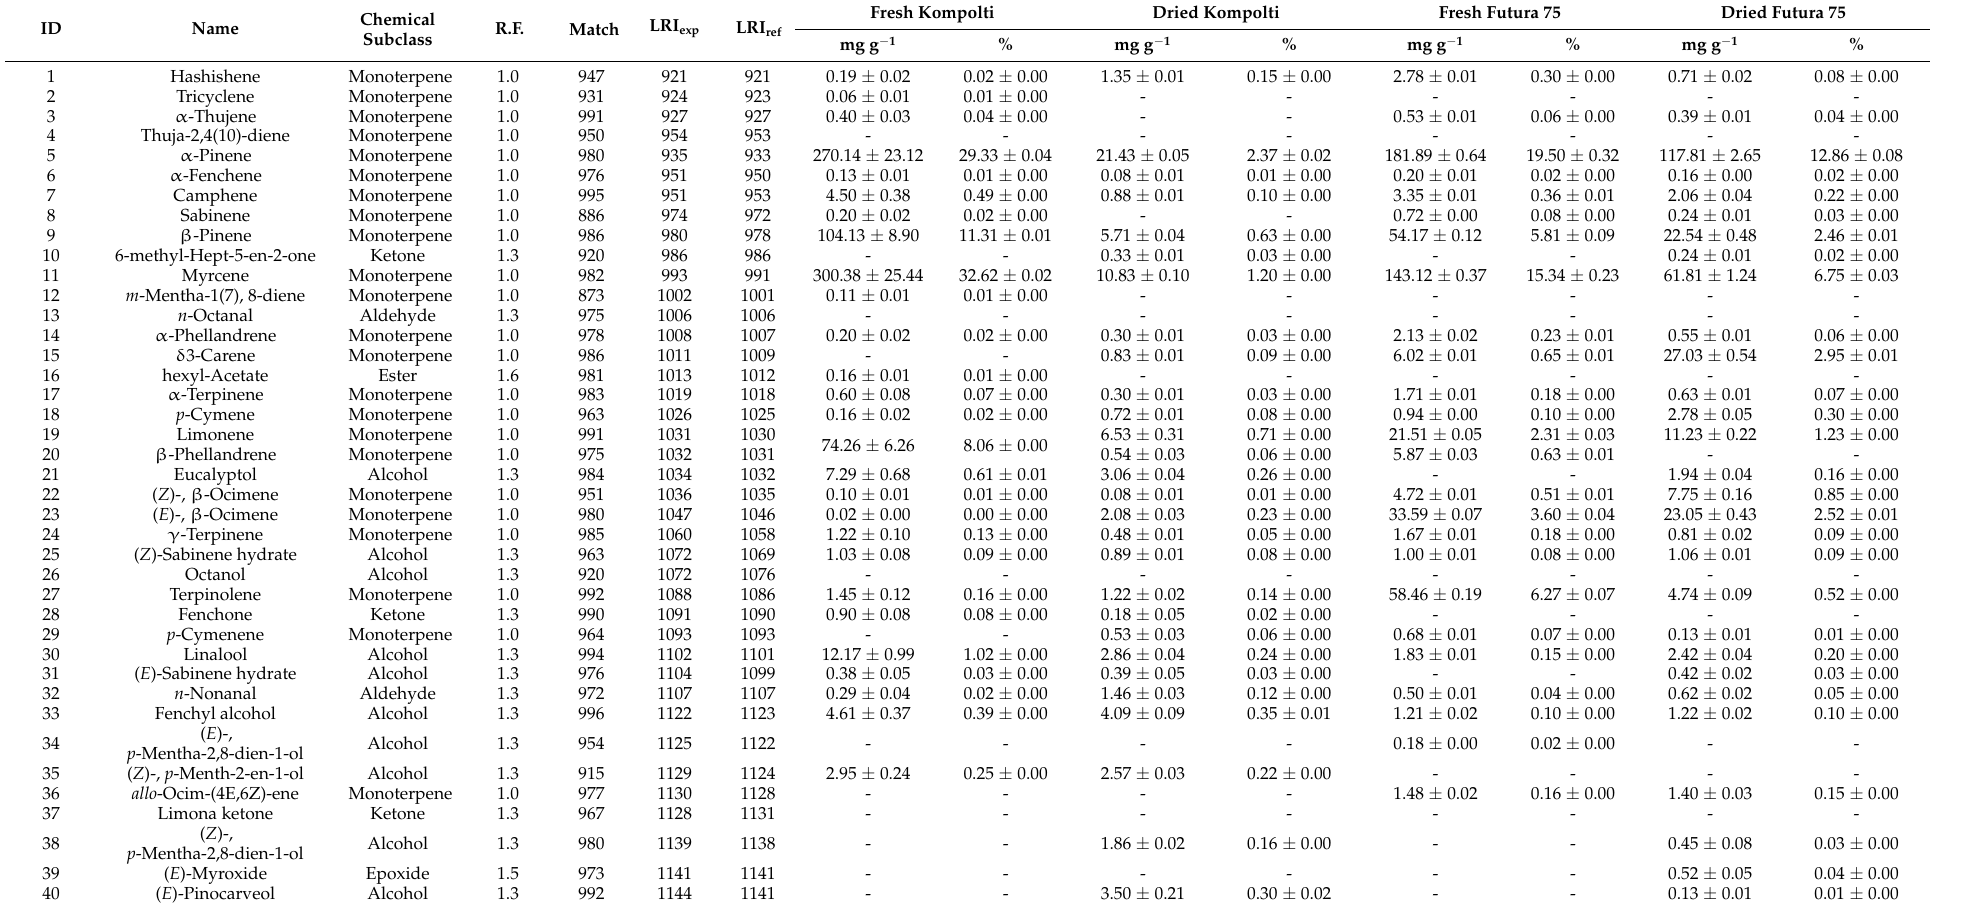
Table 1. List of volatile compounds detected in cannabis essential oils (EOs) distilled from fresh and dried inflorescences of Kompolti and Futura 75 cultivars. Abbreviations: R.F.: response factor; match: database spectral matching; LRI exp : experimental LRI; LRI ref : reference LRI. Quantitative results are expressed both in absolute manner (mg g − 1 ) and in relative percentages (%). The compounds are also grouped in monoterpene, sesquiterpene, diterpene and aliphatic hydrocarbons and as well as oxygenated compounds including aldehyde, alcohol, ester, ketone, epoxide, and cannabinoid. The cannabis EO yields are also